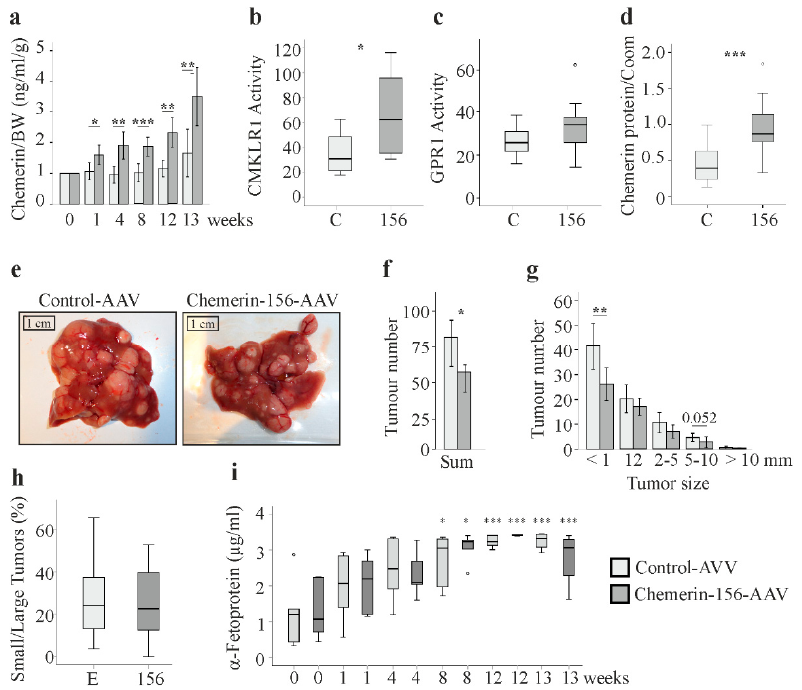
Figure 2. Chemerin protein, activity, tumor number, and α -fetoprotein. ( a ) Chemerin protein